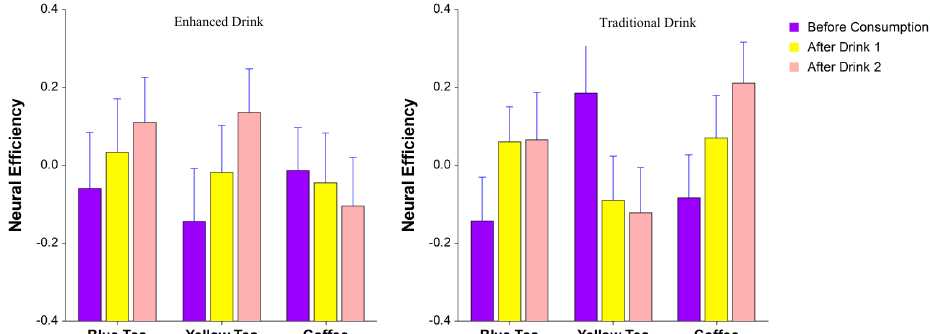
Figure 11. Comparison of neural efficiency in the Stroop task. The left graph indicates neural efficiency while participants consumed the enhanced drink. The right graph indicates neural efficiency while participants consumed the traditional drink. Whiskers represent the SEM.